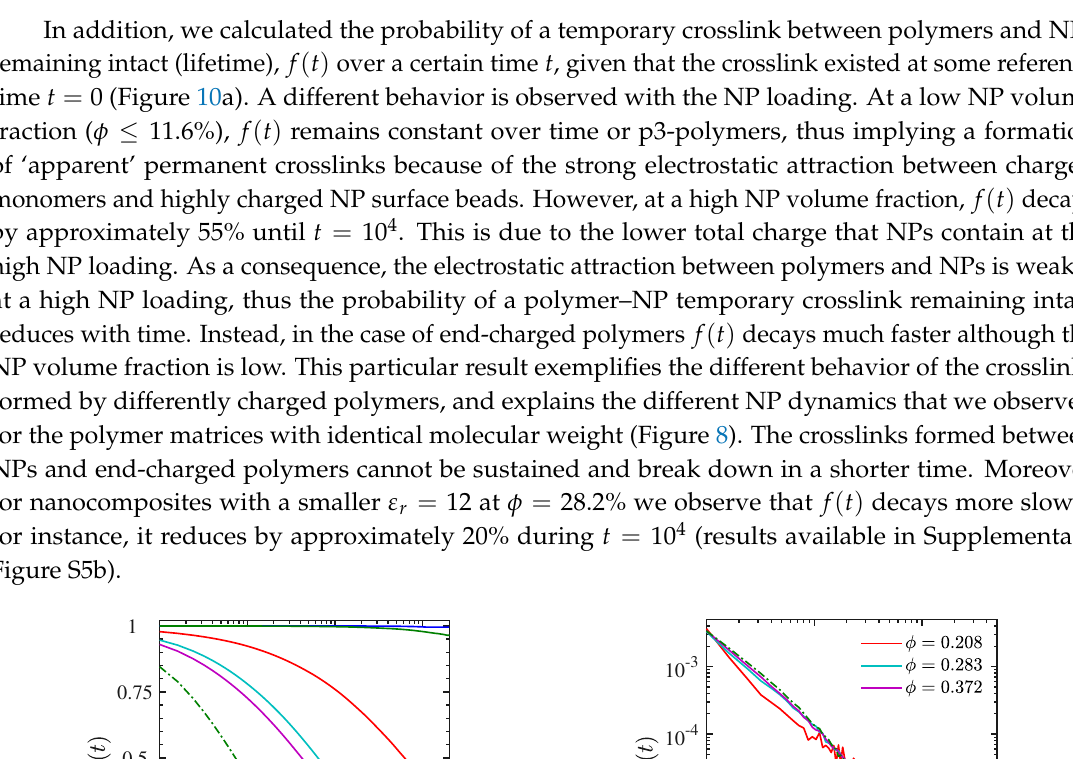
Figure 9. Probability P ( X ) of a single p3-charged chain with ( a ) N = 100 and ( b ) N = 200 monomers to crosslink X different NPs simultaneously, normalized such that ∑ i P ( X i ) = 1. Shown are results for dispersed systems at different NP volume fractions. For comparison, the dash-dotted line in ( b ) corresponds to an end-charged system at φ = 11.6%. The lines are guides to the eye.